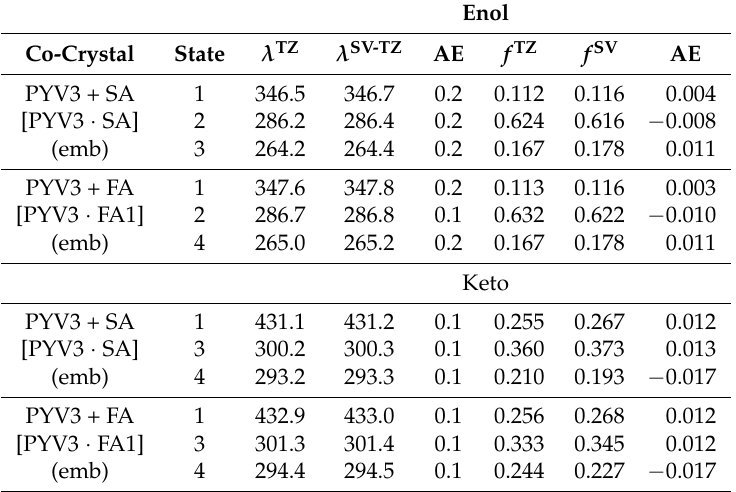
Table 4. RI-CC2 wavelengths of excitation with the def2-TZVPD (TZ) and composite (SV-TZ) methods ( λ , in nm) and def2-TZVPD (TZ) and def2-SVPD (SV) oscillator strengths, f , and absolute errors (AE) for the embedded heteromers of SA and FA1 (PYV3 + SA [PYV3 · SA] and PYV3 + FA [PYV3 ·